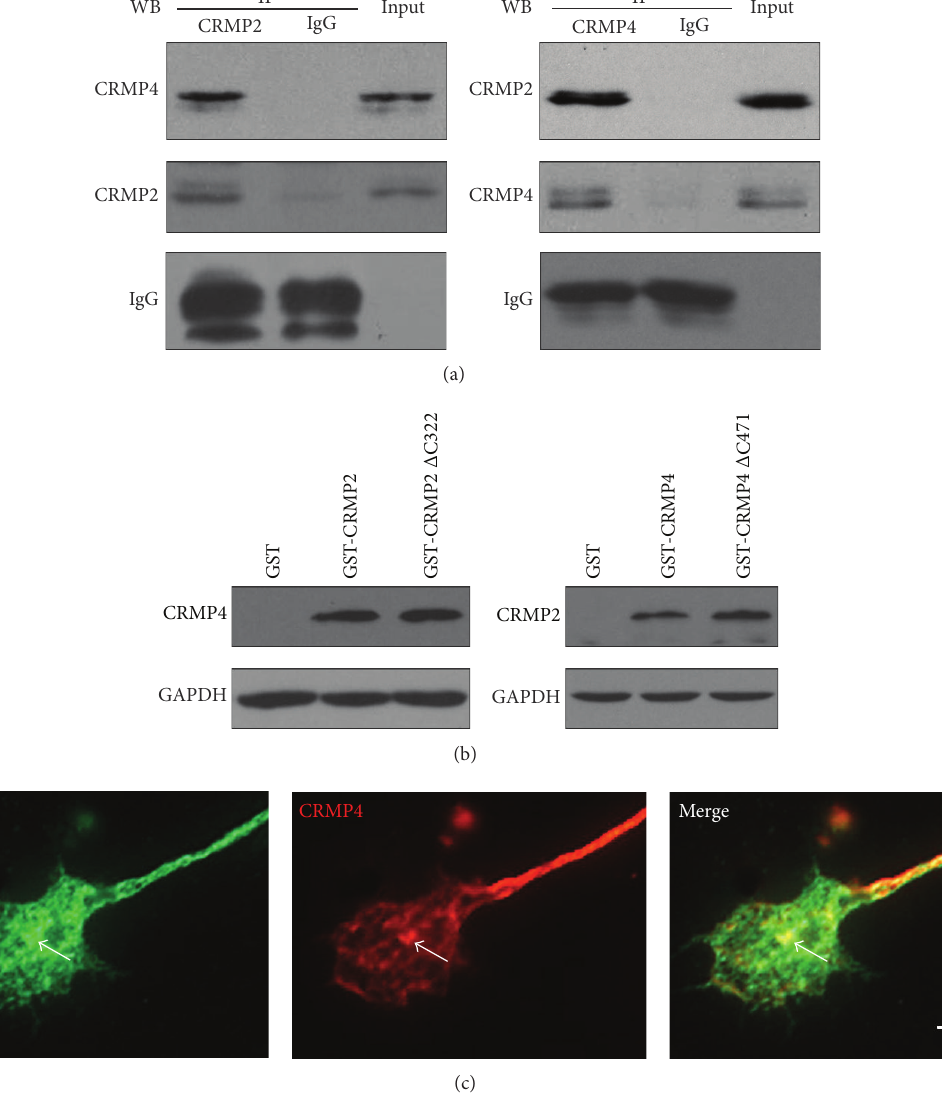
Figure 3: CRMP2 and CRMP4 form complexes in growth cones. (a) Growth cones lysates from rat brain were subjected to glutathione S-transferase- (GST-) pulldown assays using GST-CRMP2 or GST-CRMP4. The retrieved sediments were subjected to western blot analysis using the CRMP4 or CRMP2 antibodies. The GAPDH antibody was used to show equal loading. (b) Growth cones lysates from rat brain were subjected to coimmunoprecipitation (Co-IP) assays with rabbit CRMP2 and CRMP4 antibodies, and the resulting sediments were subjected to western blot analysis with mouse CRMP4 or CRMP2 antibodies. (c) Rabbit anti-CRMP2 and mouse anti-CRMP4 antibodies were used to detect endogenous proteins in the growth cones of hippocampal neurons. Scale bar: 10 𝜇